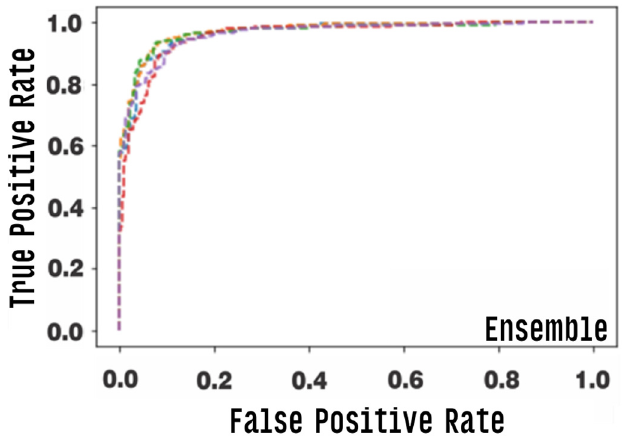
Figure 14. Example of the final response of the classifier based on the individual responses of each of the algorithms selected to compose the Ensemble.